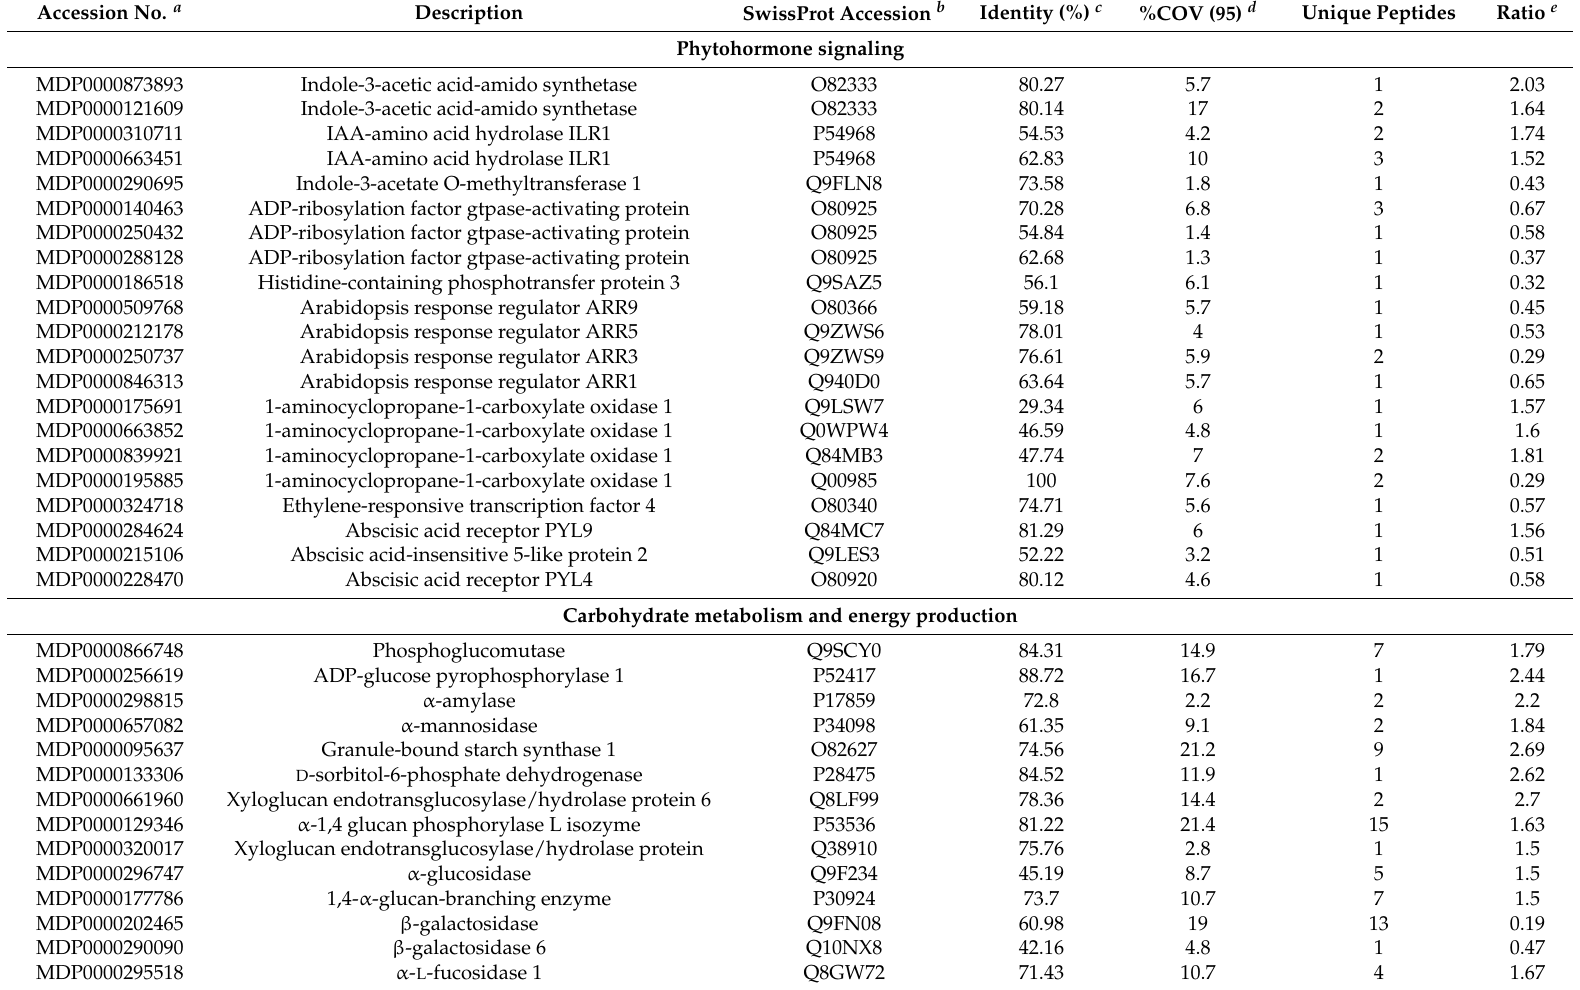
Table 2. List of proteins differently expressed in ‘T337’ basal cuttings with IBA treatment and